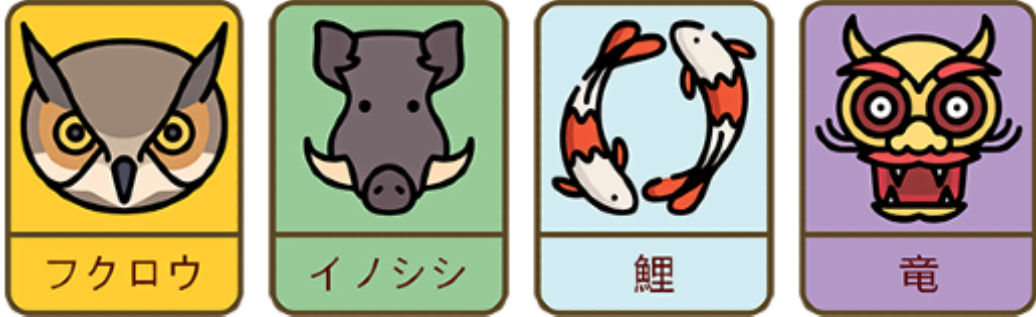
Figure 1. Examples of virtual cards in Shinpo.